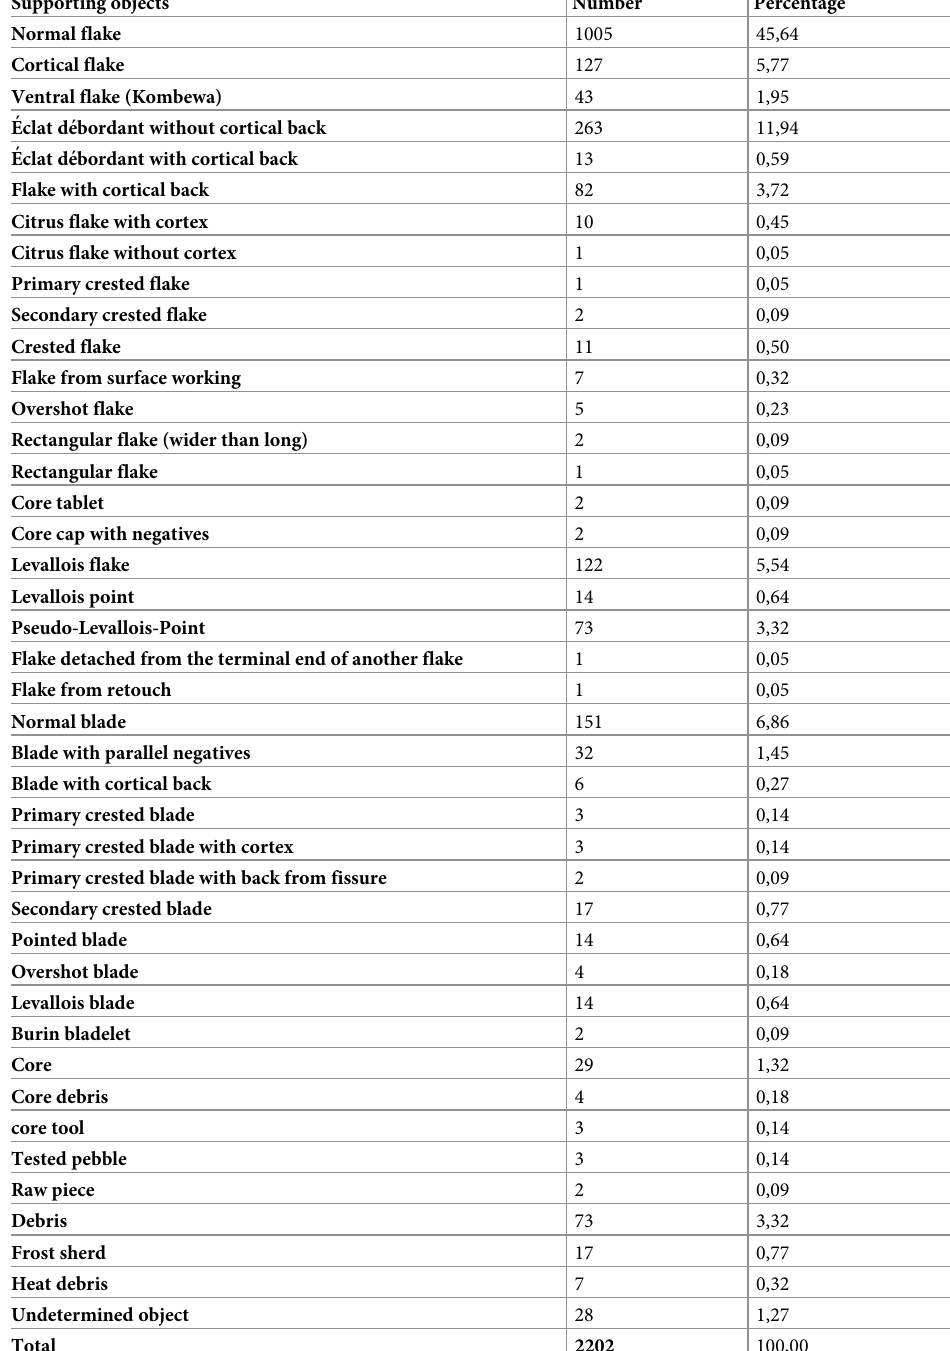
Table 3. Lithic assemblage of Heidenschmiede.